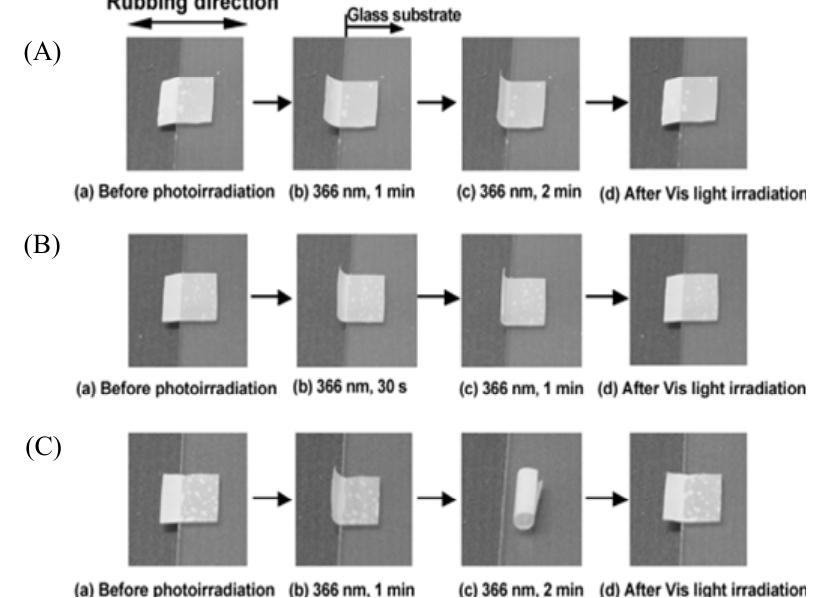
Figure 12. Photoinduced bending and unbending behavior of photo-responsive LCEs with different crosslinking densities. ( A ) LCE with 5% crosslinker; ( B ) 10% crosslinker;